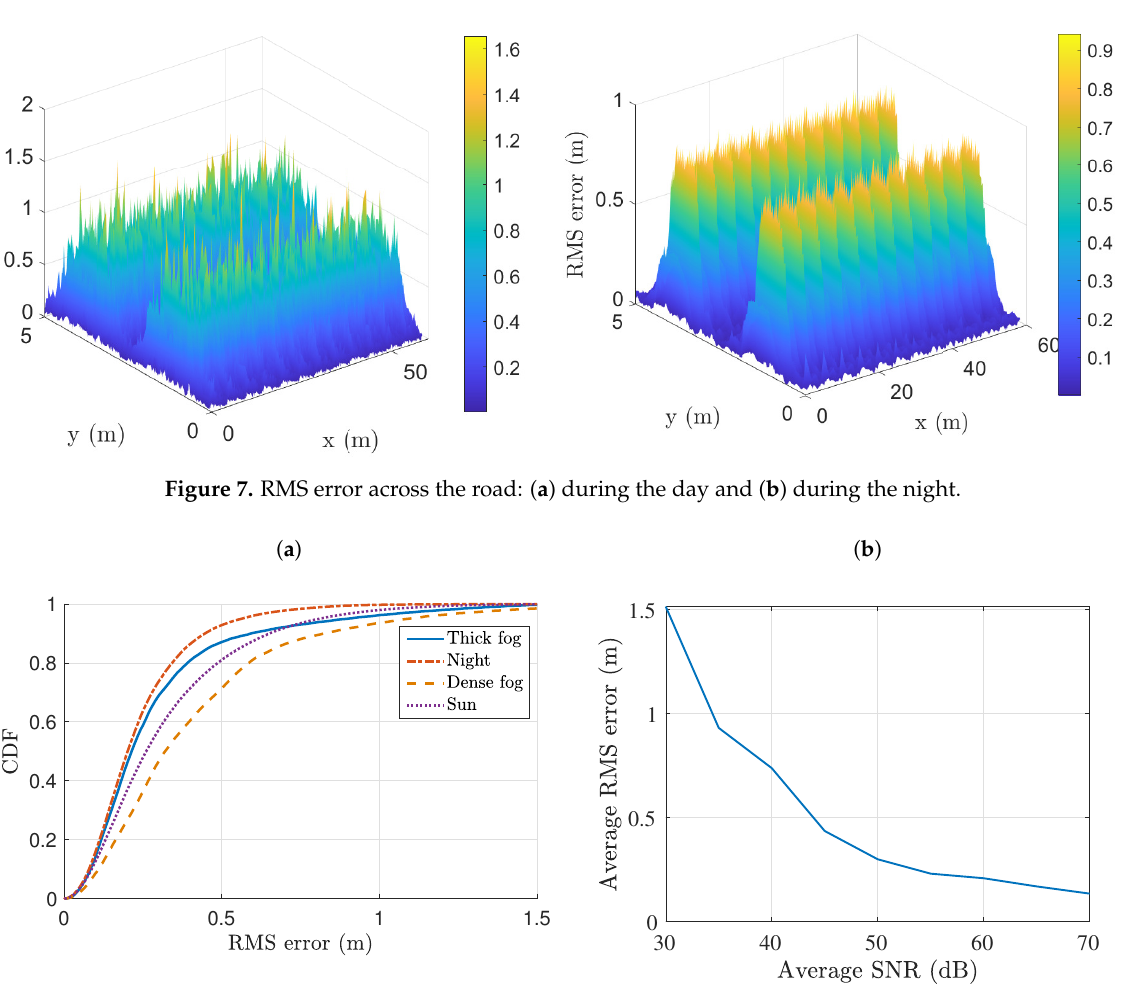
Figure 8. ( a ) CDF of VLP at different weather conditions and ( b ) average SNR versus average RMS